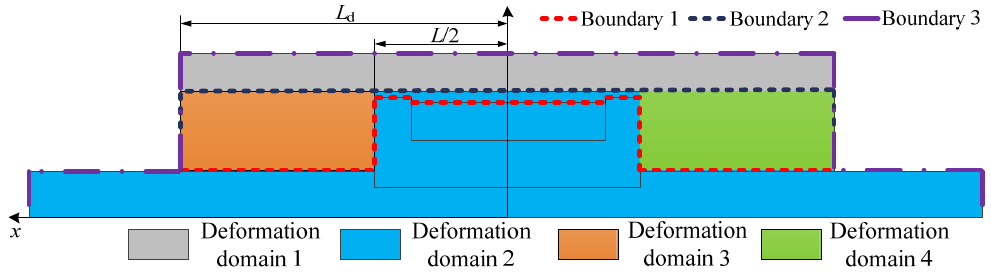
Figure 6. Deformation domain and boundary conditions of dynamic mesh.